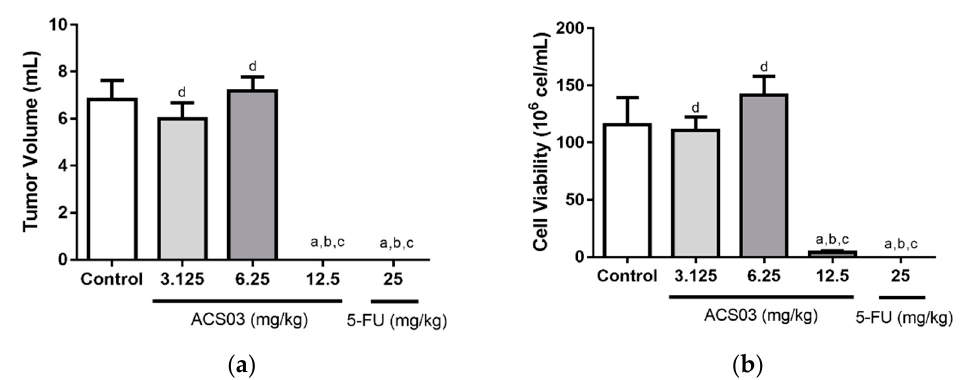
Figure 2. Effect of ACS03 (3.125, 6.25, or 12.5 mg/kg) on ( a ) tumoral volume and ( b ) cell viability. Data are presented as mean ± standard error of mean (SEM) of six animals analyzed by analysis of variance (ANOVA) followed by Tukey’s test. a p < 0.05 compared to tumor control group, b p < 0.05 compared to 3.125 mg/kg dose. c p < 0.05 compared to compared to 6.25 mg/kg dose. d p < 0.05 compared to compared to 12.5 mg/kg dose.